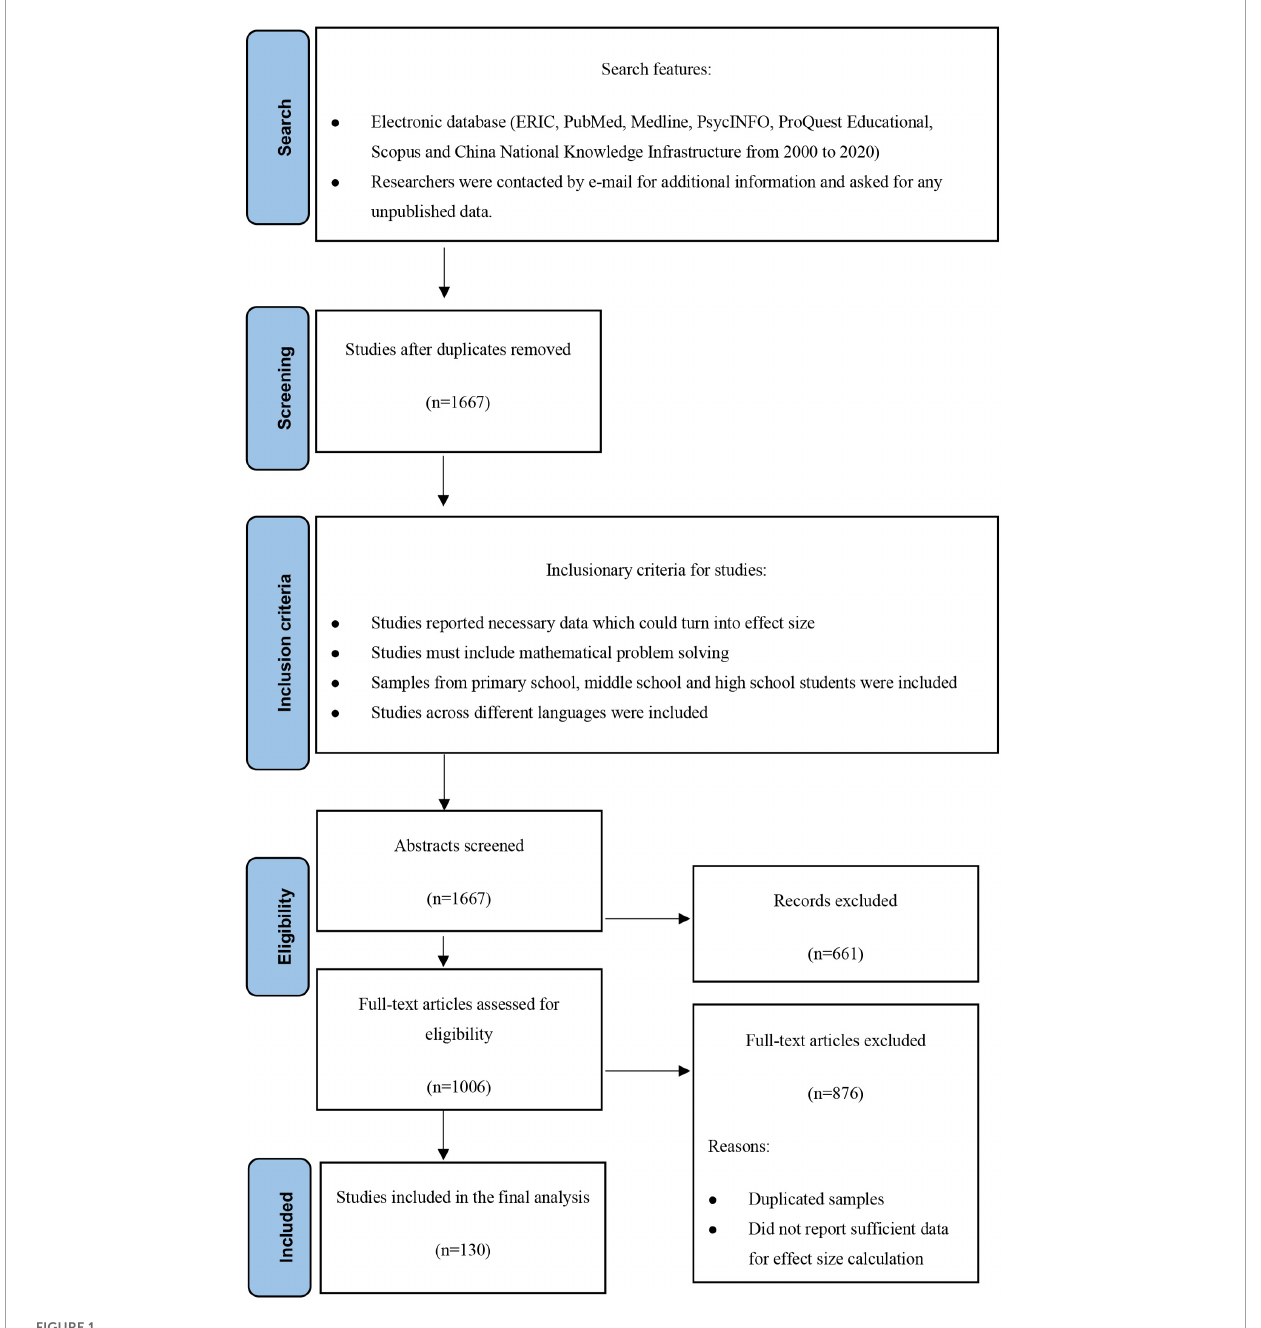
FIGURE1 Flow diagram for search and inclusion on